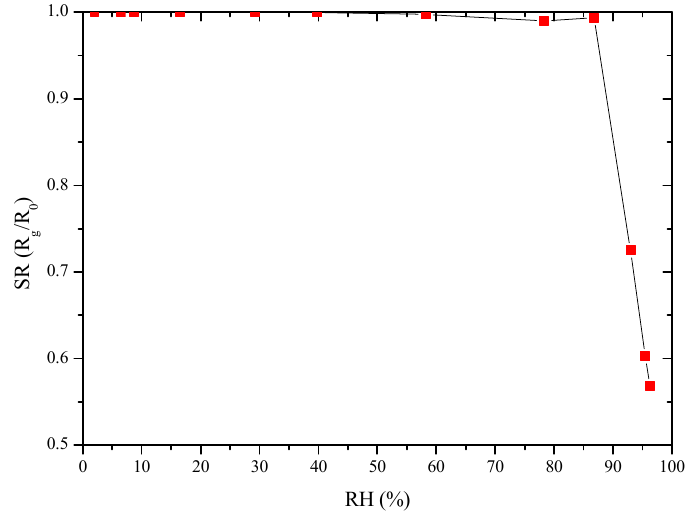
Figure 8. GC sensor response towards RH at RT.